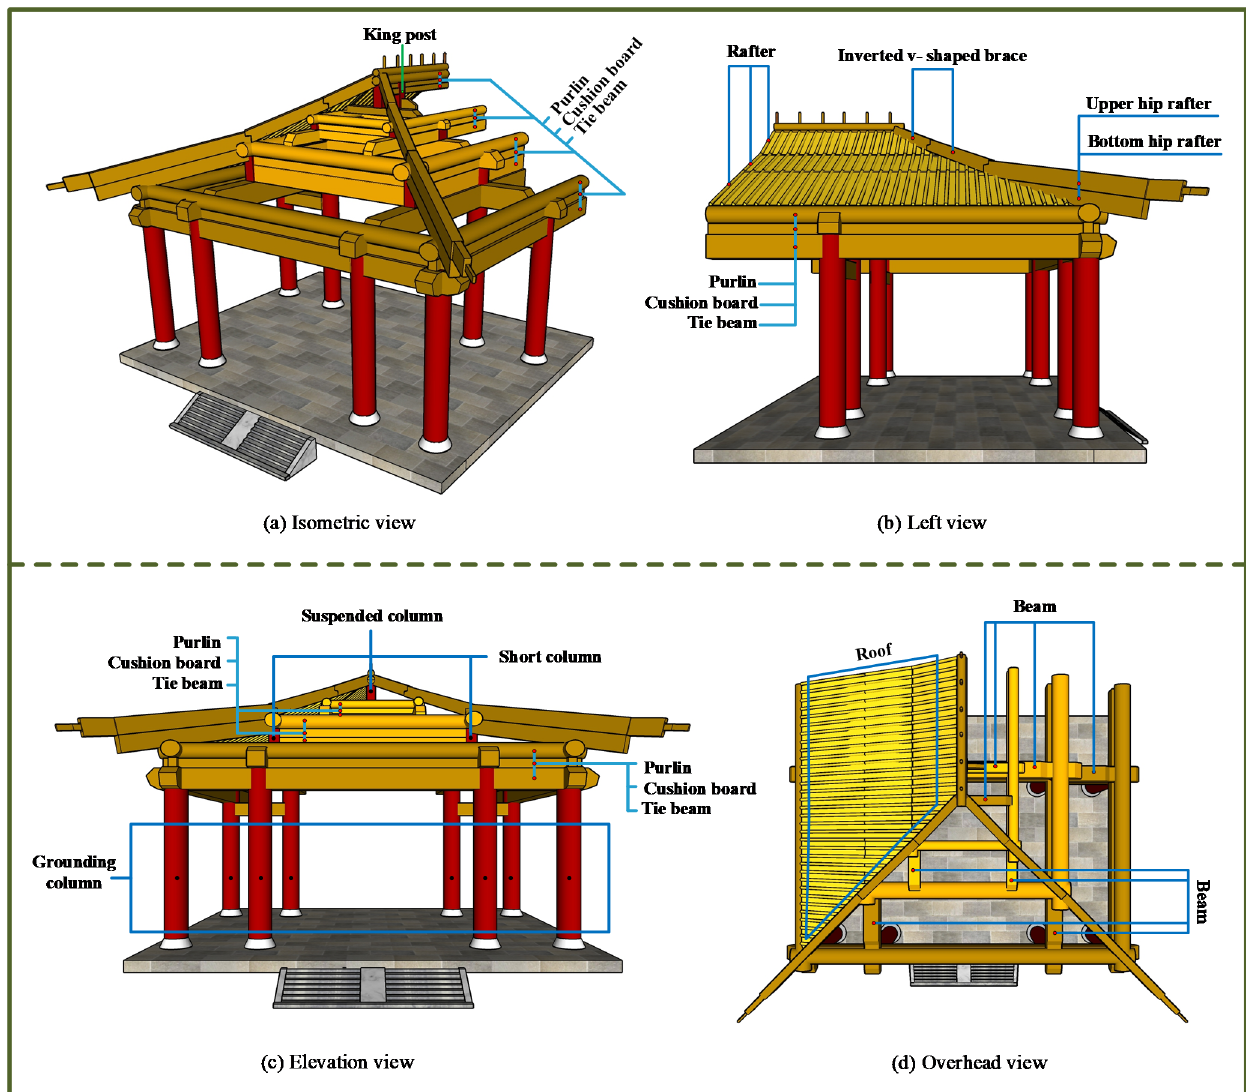
Figure 3. The model of a part of ancient Chinese palace wooden structure.